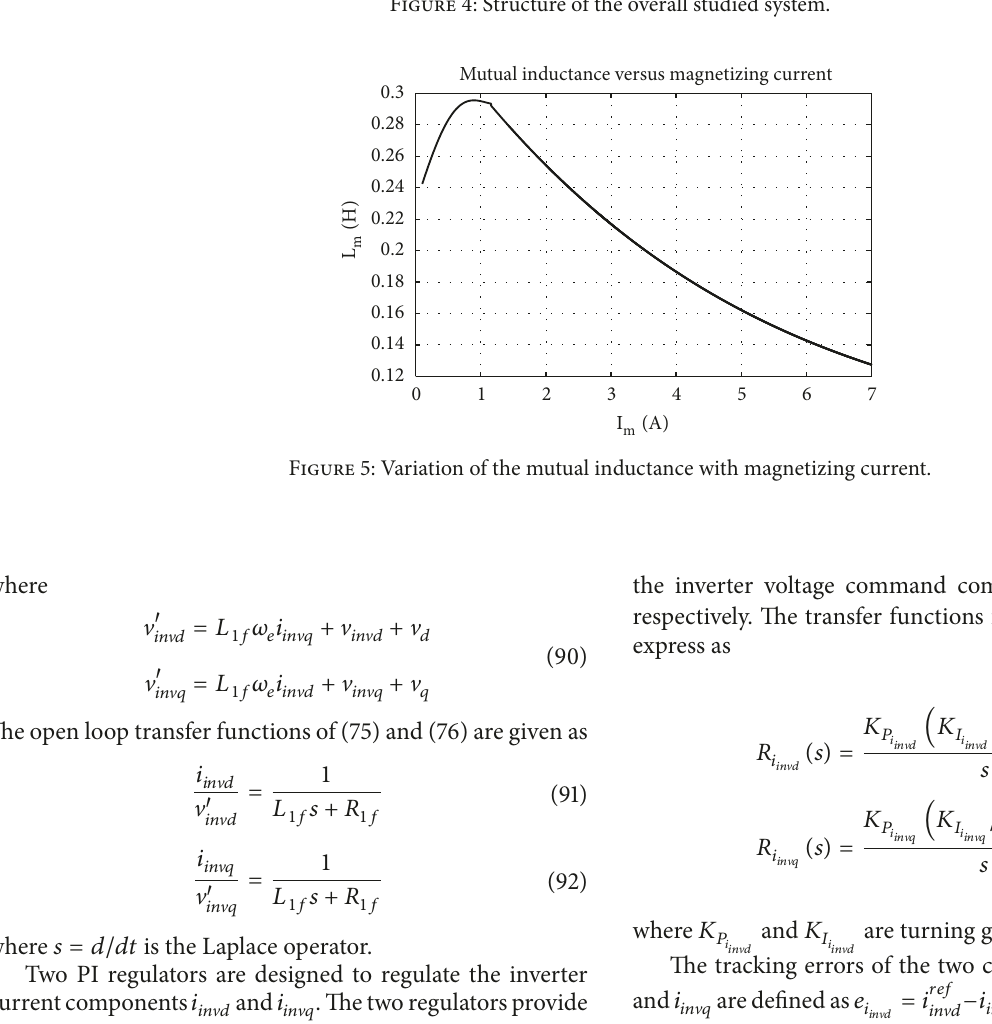
Figure 4: Structure of the overall studied system.